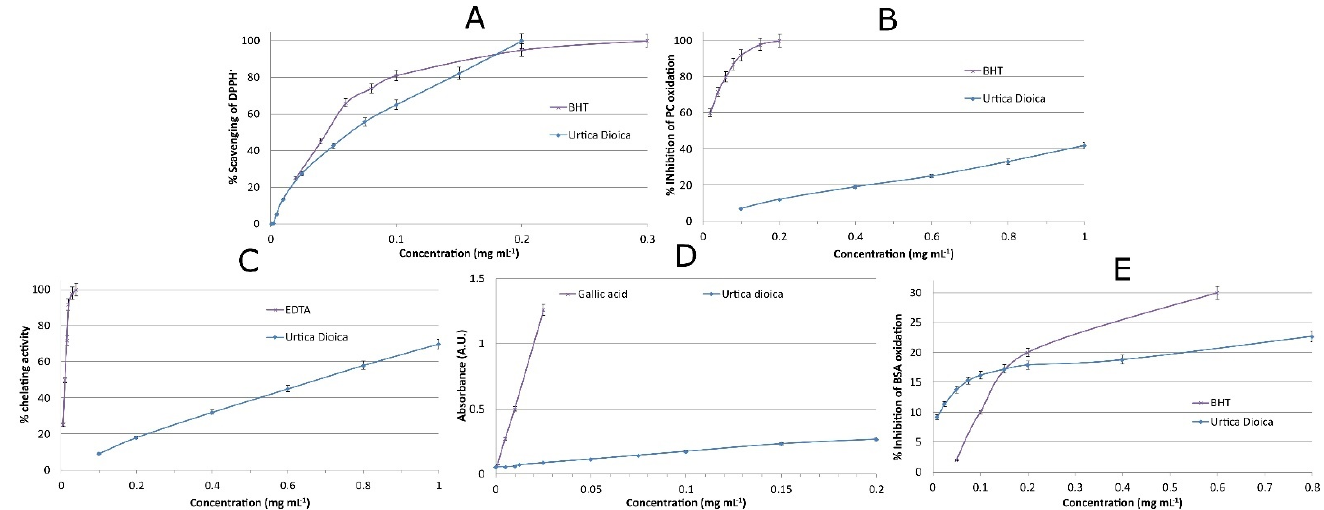
Figure 4. ( A ) Free radical scavenging, ( B ) inhibition of lipid oxidation, ( C ) metal chelating, ( D ) reducing power, and ( E ) prevention of protein oxidation properties of Urtica dioica L. extract.